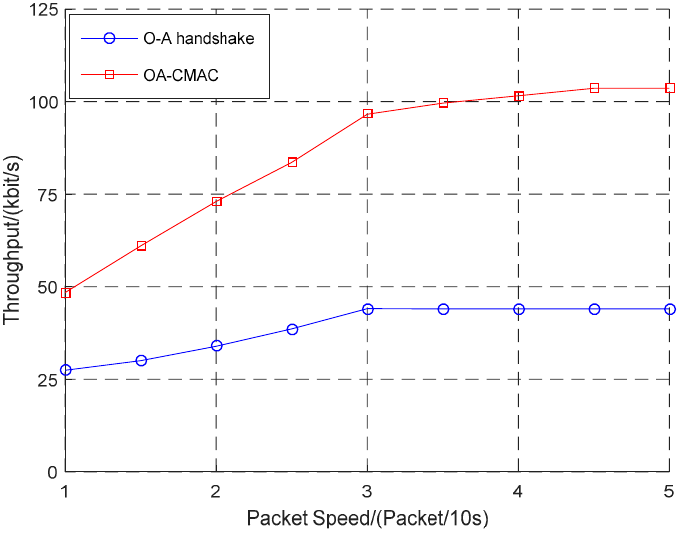
Figure 6. Comparison of three protocol throughputs when the optical handshaking success rate was 50%.